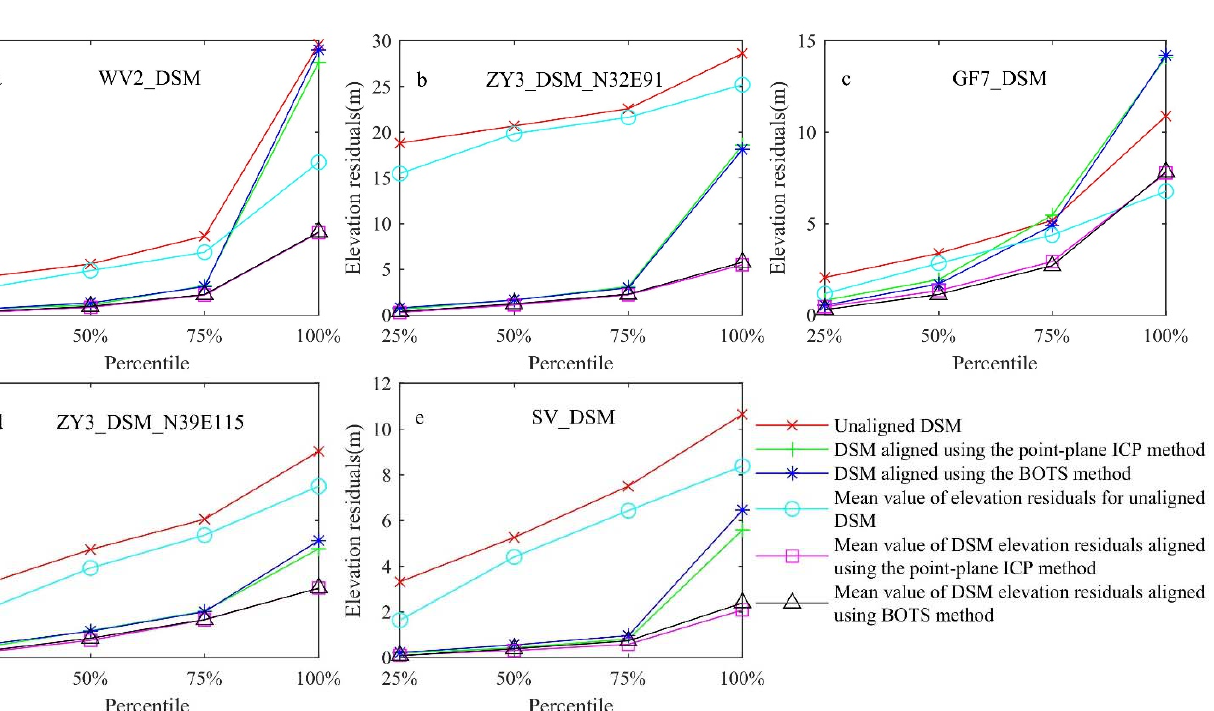
Figure 10. DSM elevation accuracy evaluation.